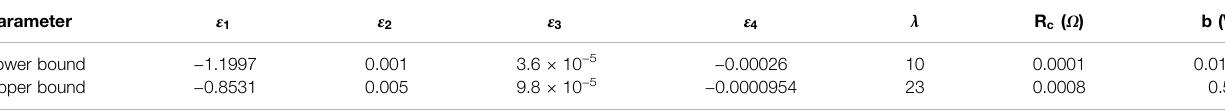
TABLE 1 | Range of PEMFC parameters for identi fi cation.